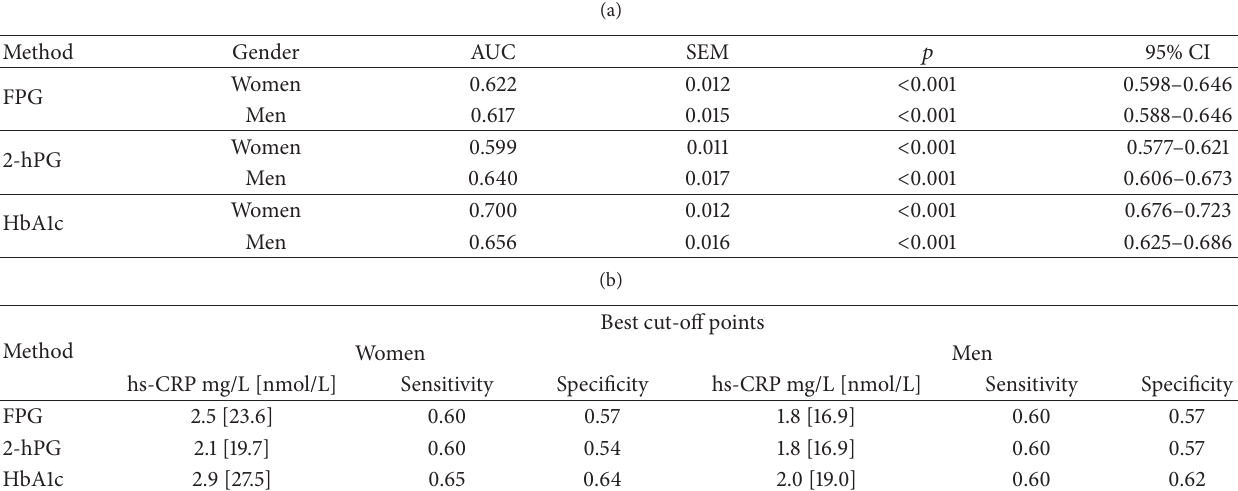
Table 4: (a) The area under the curve (AUC) and (b) the best cut-off points for hs-CRP to identify newly detected DM based on the FPG, 2-hPG, or HbA1c criteria in women and